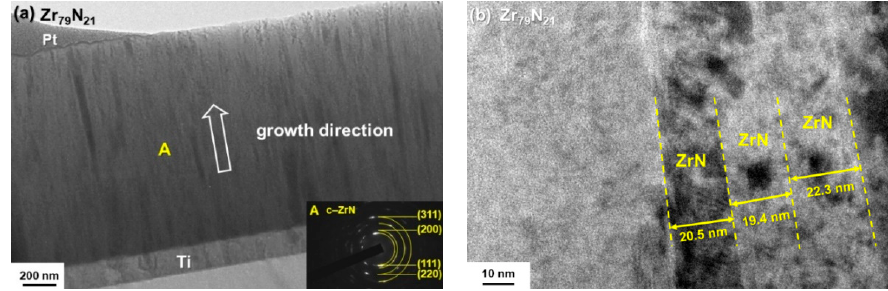
Figure 9. ( a ) Cross ‐ sectional transmission electron microscopy (TEM) image and selected area electron diffraction (SAED) pattern and ( b ) high ‐ magnification TEM image of the Zr 71 N 29 films.